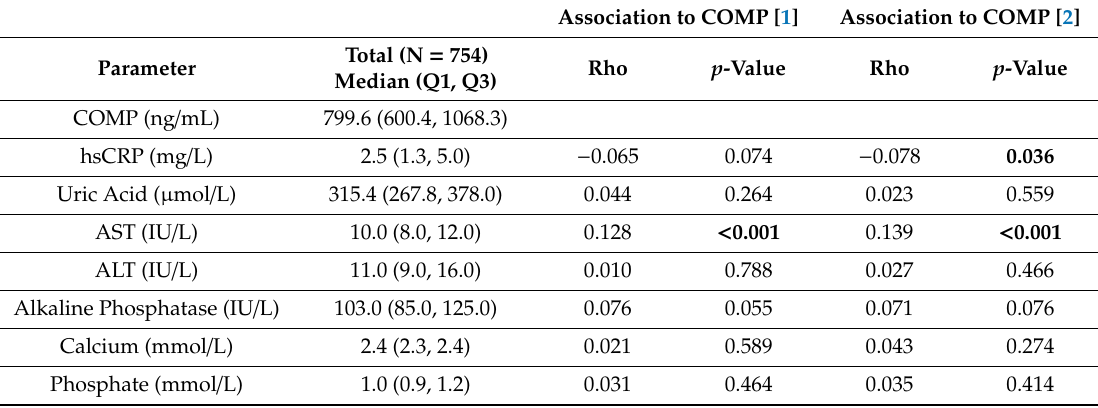
Table 1. Partial Spearman Rank Correlation Coe ffi cients for sCOMP at baseline. Significant associations are highlighted in bold. [1] Adjusted for age, sex, and BMI. [2] Adjusted for age, sex, BMI and